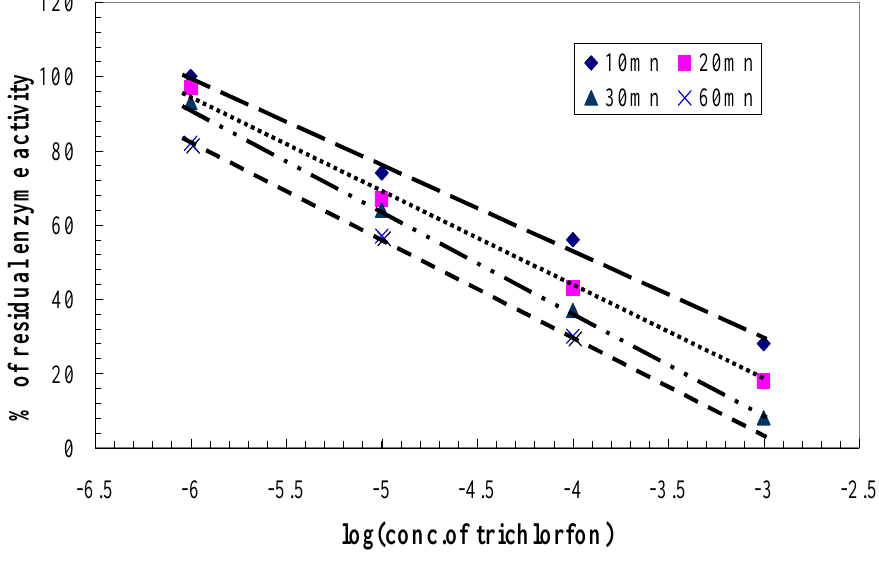
Figure 3. Inhibition effect on the BuChE-BSA FET sensor by trichlorfon. Percent of residual enzyme activity as fuction of trichlorfon